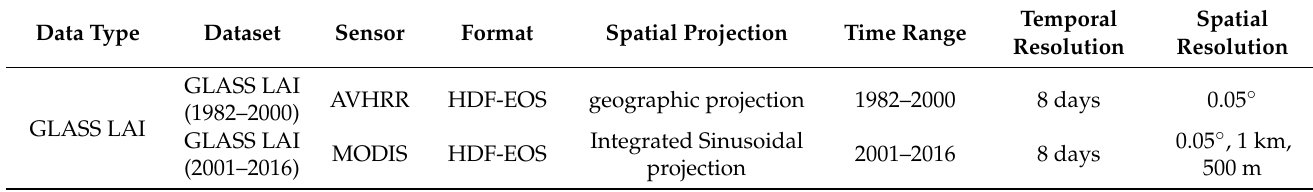
Table 1. List of all the LAI data used in this